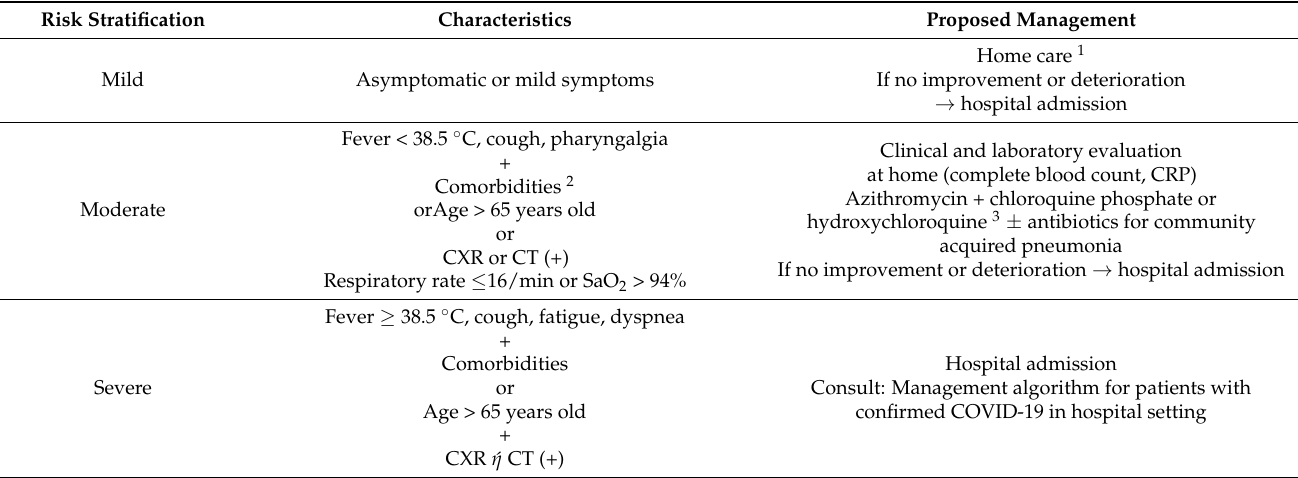
Table 2. Management of confirmed COVID-19 at home.